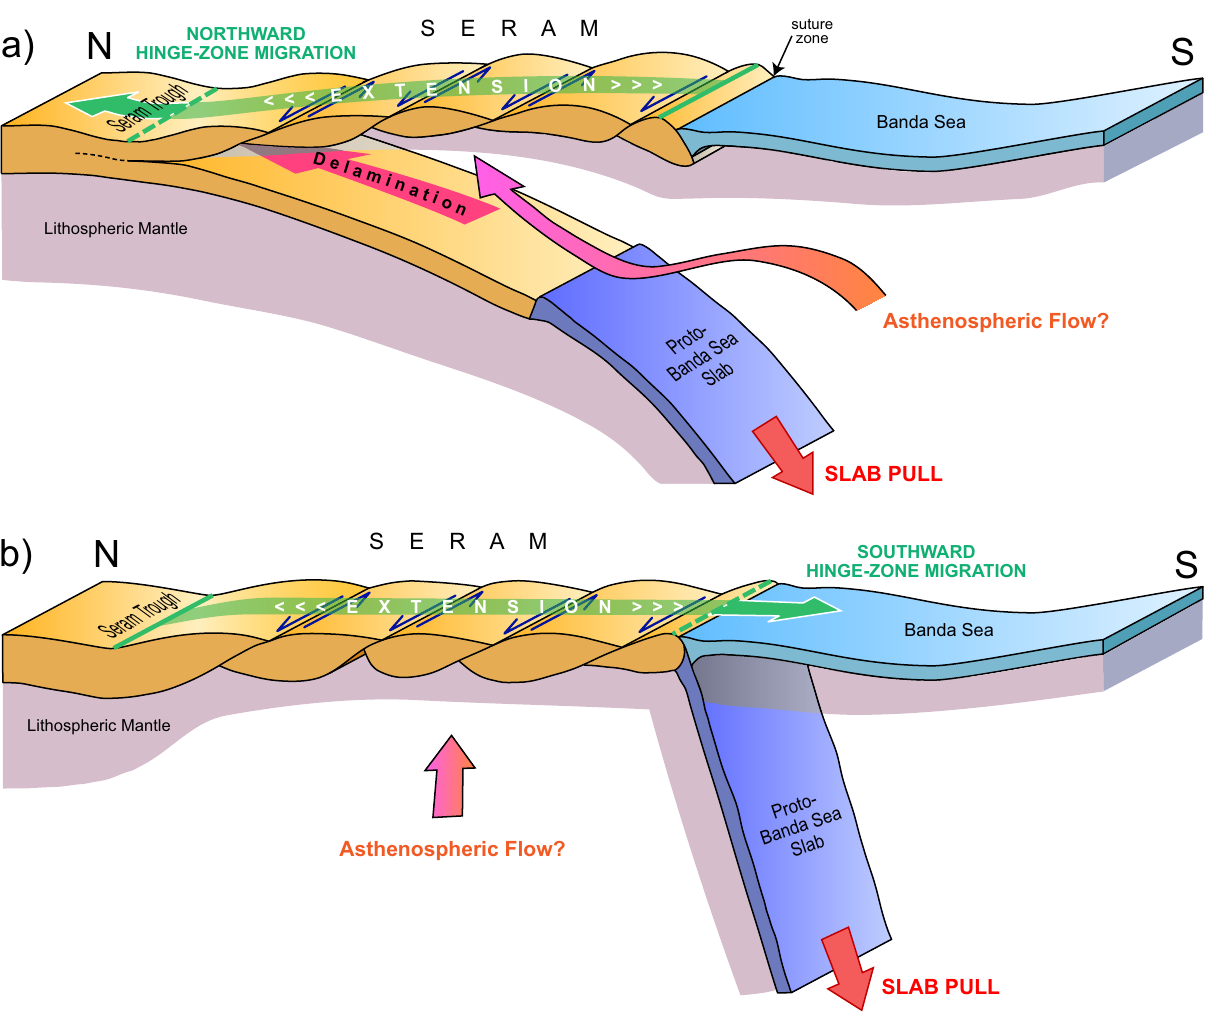
Fig. 22. Two possible tectonic models for extreme extension on Seram: (a) Delamination Model – northward migration of the subduction hinge-zone (green dotted line) has propagated beneath Seram causing lower crustal delamination and mid/upper-crustal extension; (b) Hinge Zone Reversal Model – after complete subduction of the Proto-Banda Sea, continued slab pull has driven a reversal in hinge-zone migration direction due to the resistance of the continental crust to subduction, causing extension within the Australian continental margin to the north. Note that in both scenarios, slab rollback operates to the east ( Hall, 2012) and the detachment faults also have left-lateral strike-slip components to their motion. Both cross sections are drawn schematically. See Fig. 21a for details on the boudinaged section of extended crust that is depicted by both models. See text for